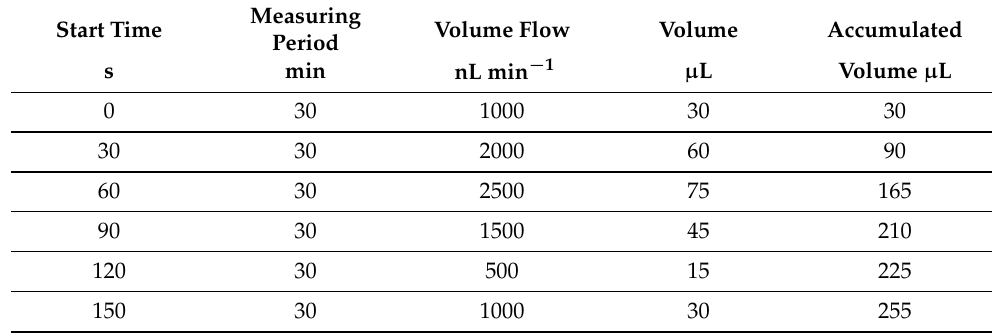
Table 3. Investigated dynamic flow profile containing step changes in flow